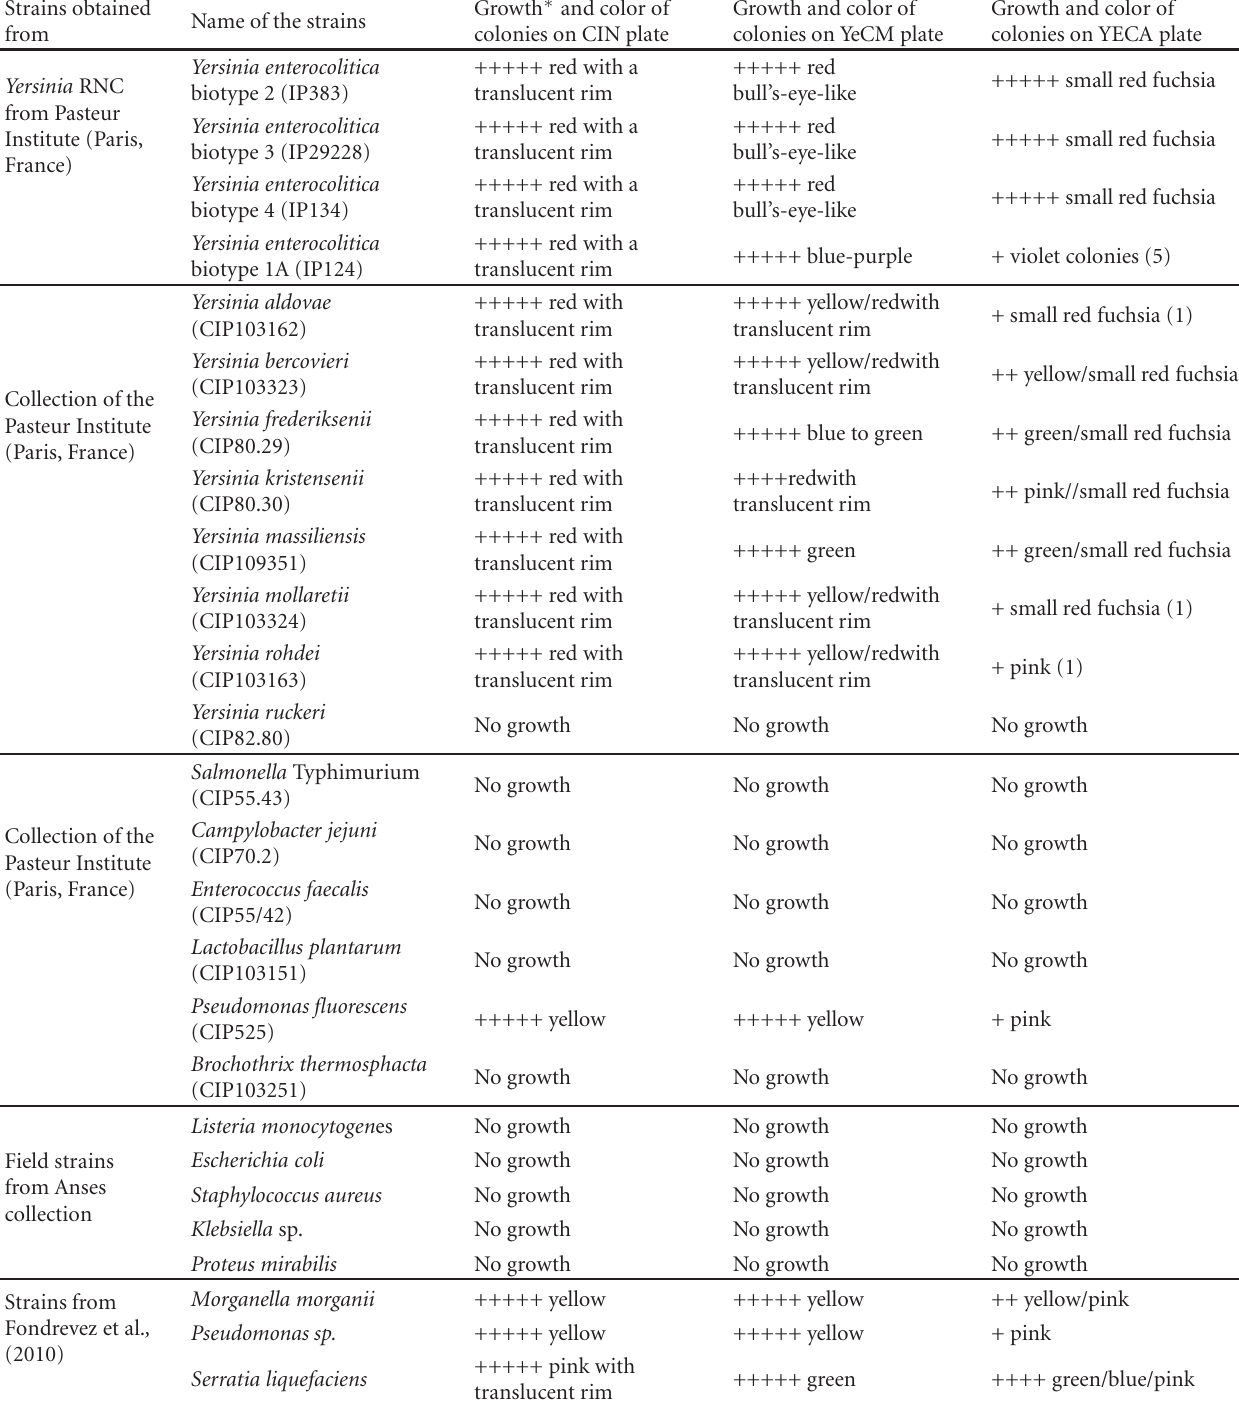
Table 1: Growth and color of colonies of strains used to test the specificity of YECA